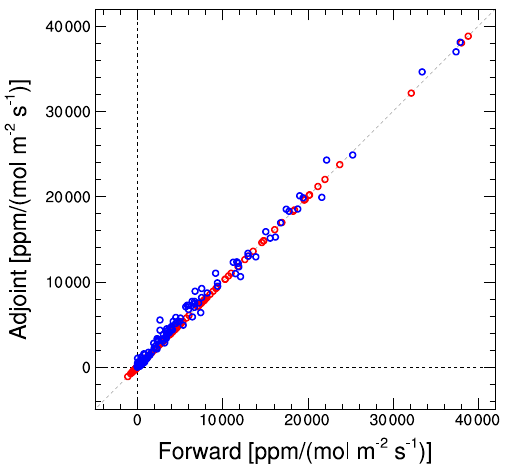
Figure 6. The scatter diagram showing 160 concentration values simulated by the forward model at the observation points versus their corresponding adjoint footprint values at the flux point X . The open red circles denote values from the linear model setup (the for- ward model without the flux limiter and the discrete adjoint model), while the open blue circles denote values from the nonlinear model setup (the forward model with the flux limiter and the continuous adjoint